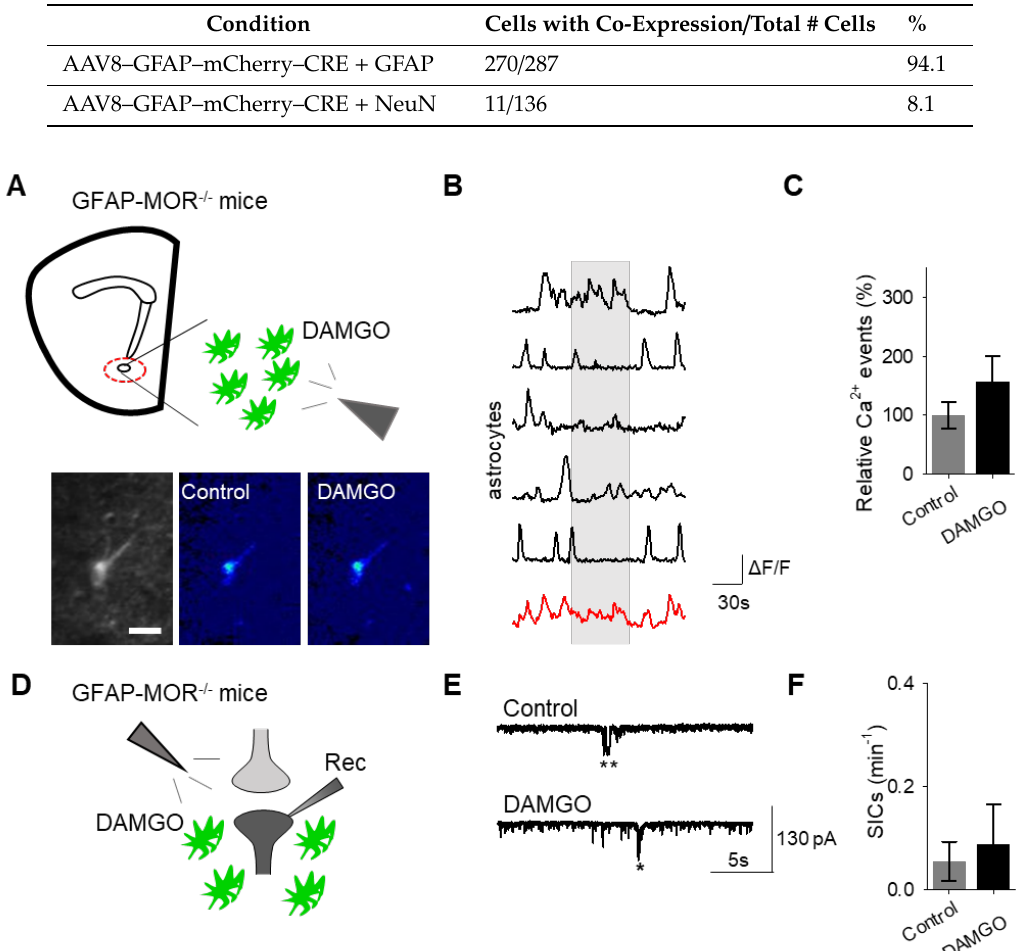
Table 2. AAV8–GFAP–mCherry–CRE viral vector specificity